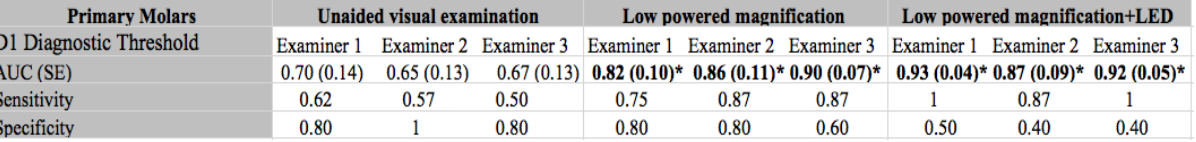
Table 7. Area under the ROC curve (Standard Error), sensitivity and specificity at D1 diagnostic threshold in primary teeth. AUC+Area under the curve; SE=standard error * Statistically significant difference (p<0.05)